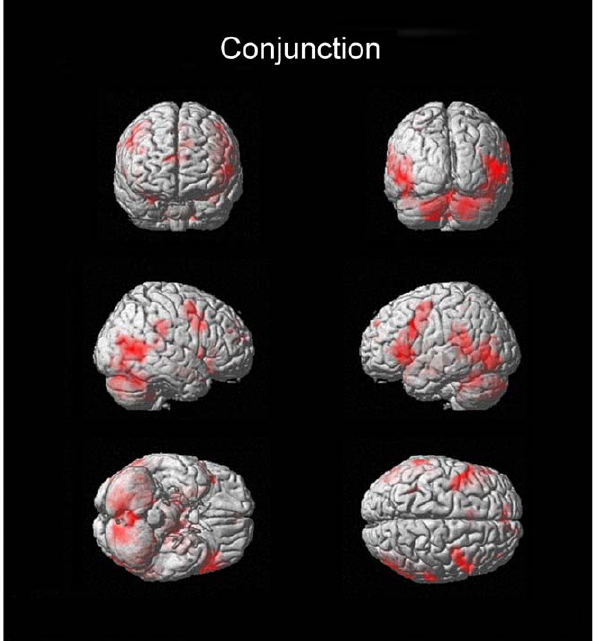
Figure 4. Three-dimensional rendered images of areas of significant activation for the same contrast as Figure 3. Note the involvement of the frontal operculum, temporo-occipital regions, cerebellum, and lateral temporal, premotor as well as motor cortices.